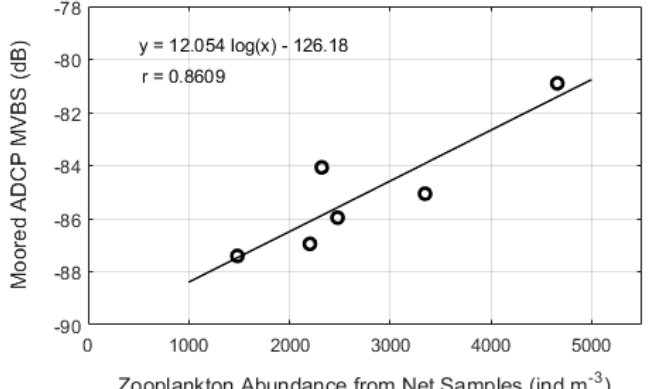
Figure 8. The relationship between the mean volume backscattering strength (dB) around the SSL and zooplankton abundance (ind m − 3 ) from net samples. The x-axis is the two dominant zooplankton species abundance ( Oithona sp. and Paracalanus sp.) measured in the laboratory while the y-axis is the averaged MVBS from moored ADCP over 30 minutes around the biological sampling time.